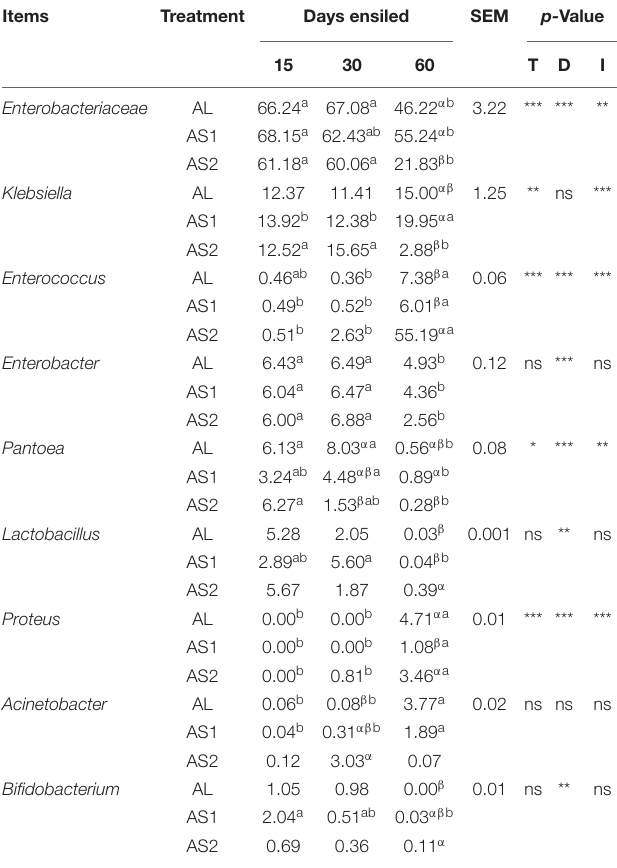
TABLE 7 | Relative abundance of genera (%) of the alfalfa